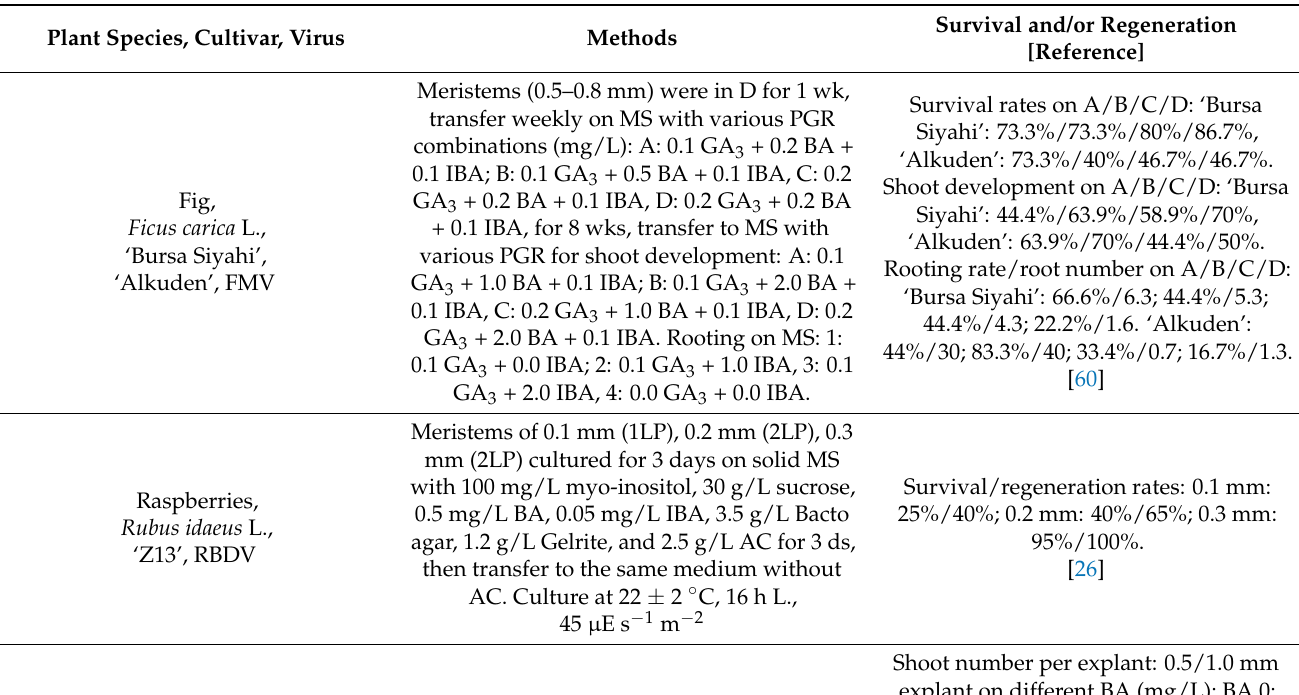
Table 1. Results and details of meristem cultures